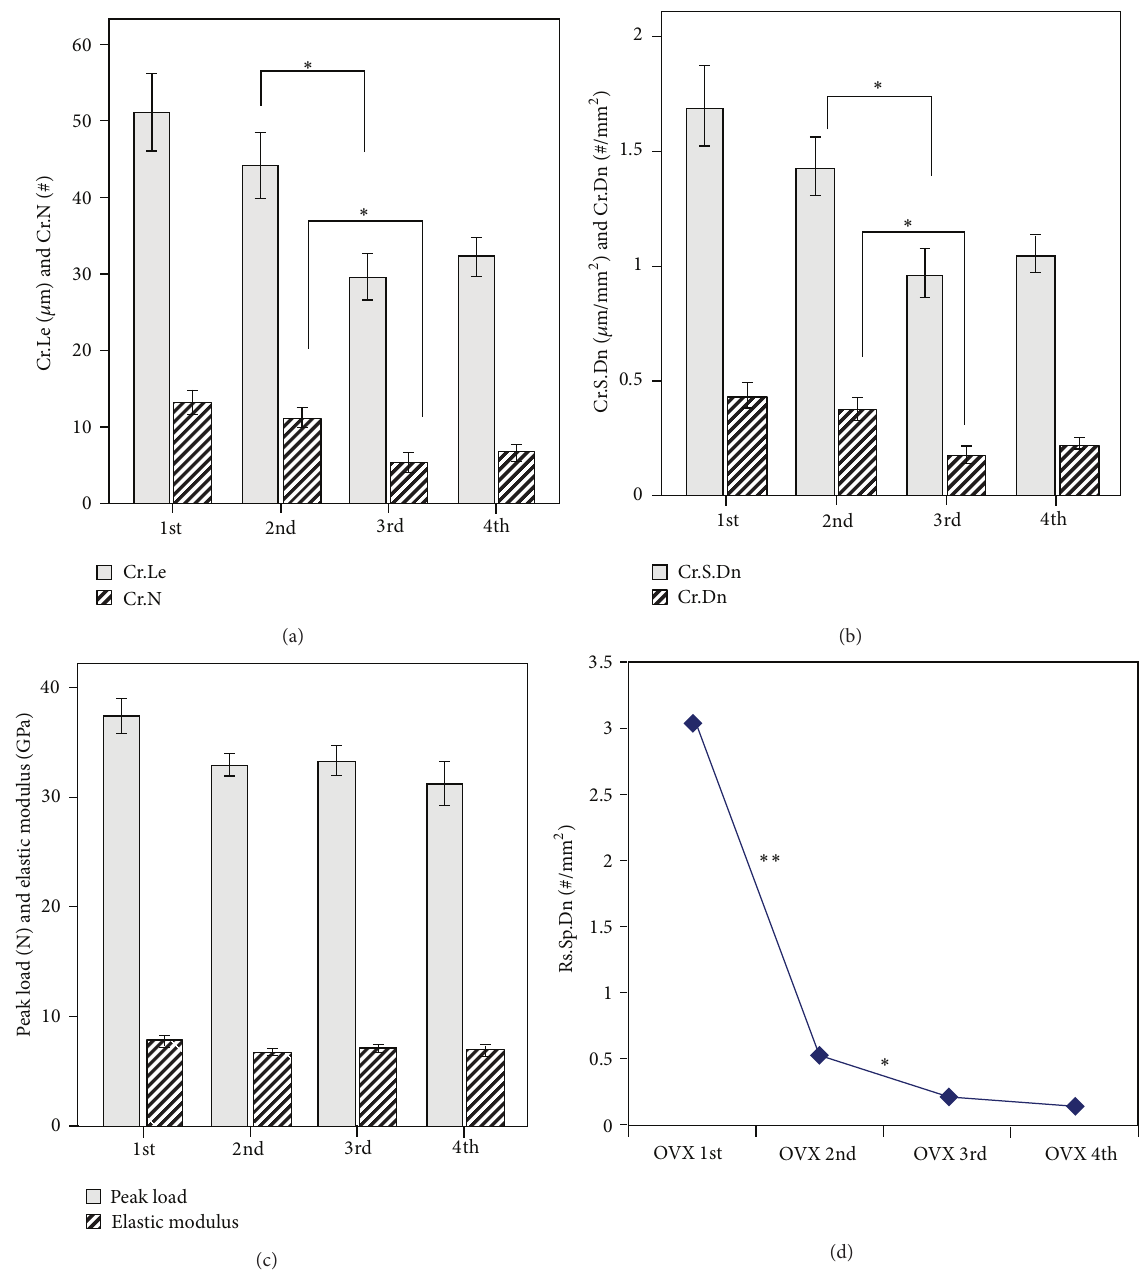
∗∗∗3.5 Figure 3: Parameters and mechanical properties of microcracks and absorptive spaces versus time. Specific values are listed in Table 1. (a) Average microcrack length (Cr.Le) and average number of microcracks (Cr.N), (b) microcrack surface density (Cr.S.Dn) and microcrack density (Cr.Dn), (c) peak load and modulus of elasticity, and (d) absorptive lacunar density. ∗ 𝑃 < 0.05 , ∗∗ 𝑃 < 0.01